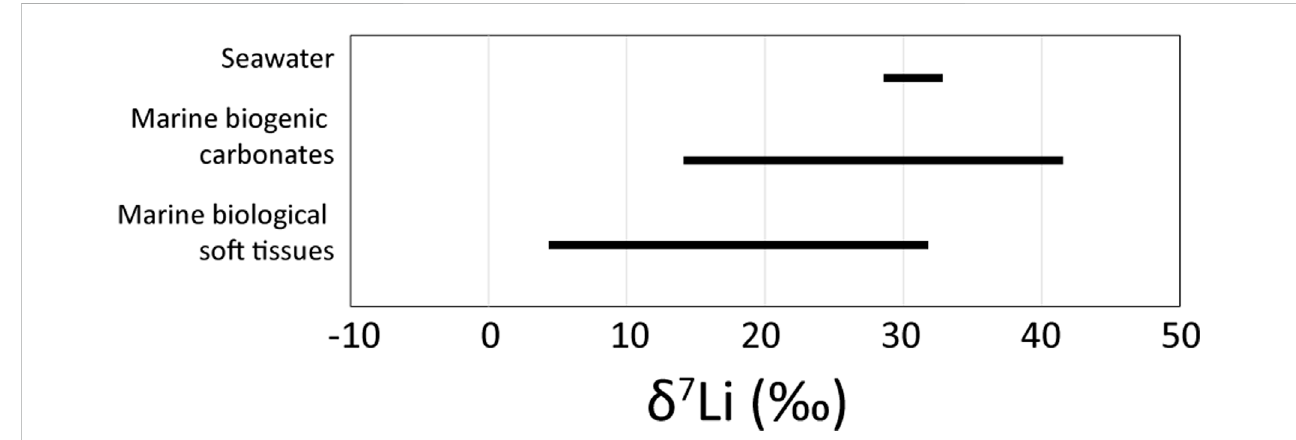
FIGURE 6 Compilation of Li isotope composition of modern marine biogenic carbonates (Dellinger et al., 2018) and soft tissues (this study). δ 7 Li value of modern seawater is homogeneous [31.3 ‰ ± .8 ‰– (Thibon et al., 2021b) — 31.0 ‰ ± .5 ‰ , Marriott et al. (2004)] and shown for